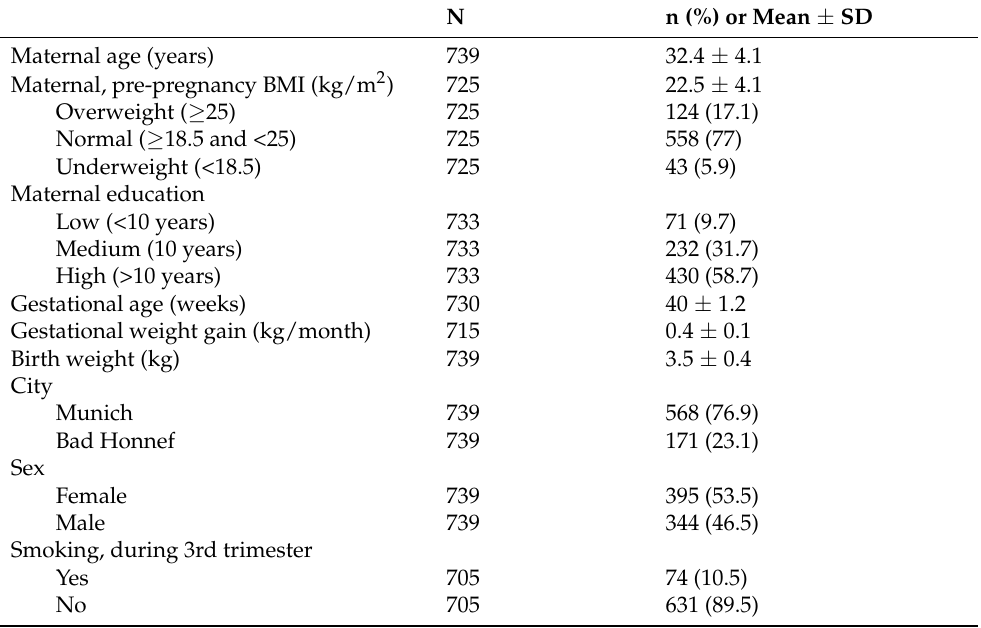
Table 1. Study population